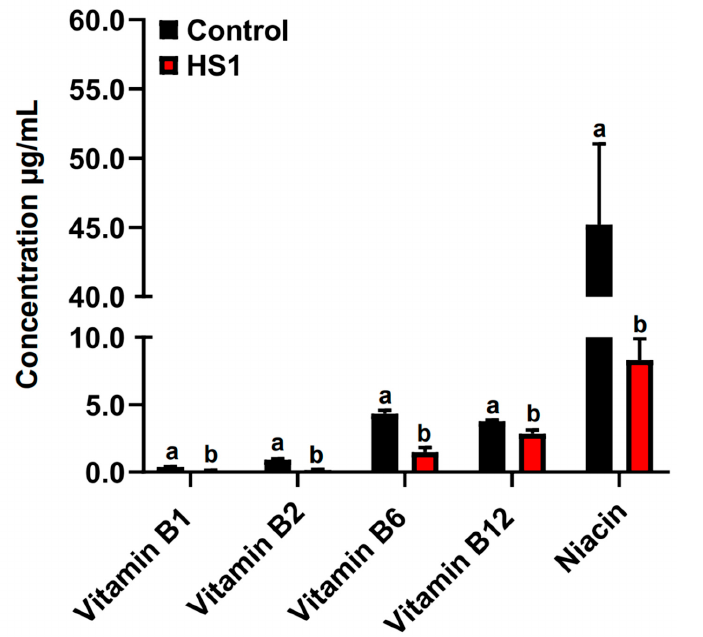
Figure 2. The concentrations of vitamins B1, B2, B6, B12, and niacin in the rumen fluid of control and HS2 animals. The different letter indicated significantly different ( p < 0.05) of the same B-vitamin.